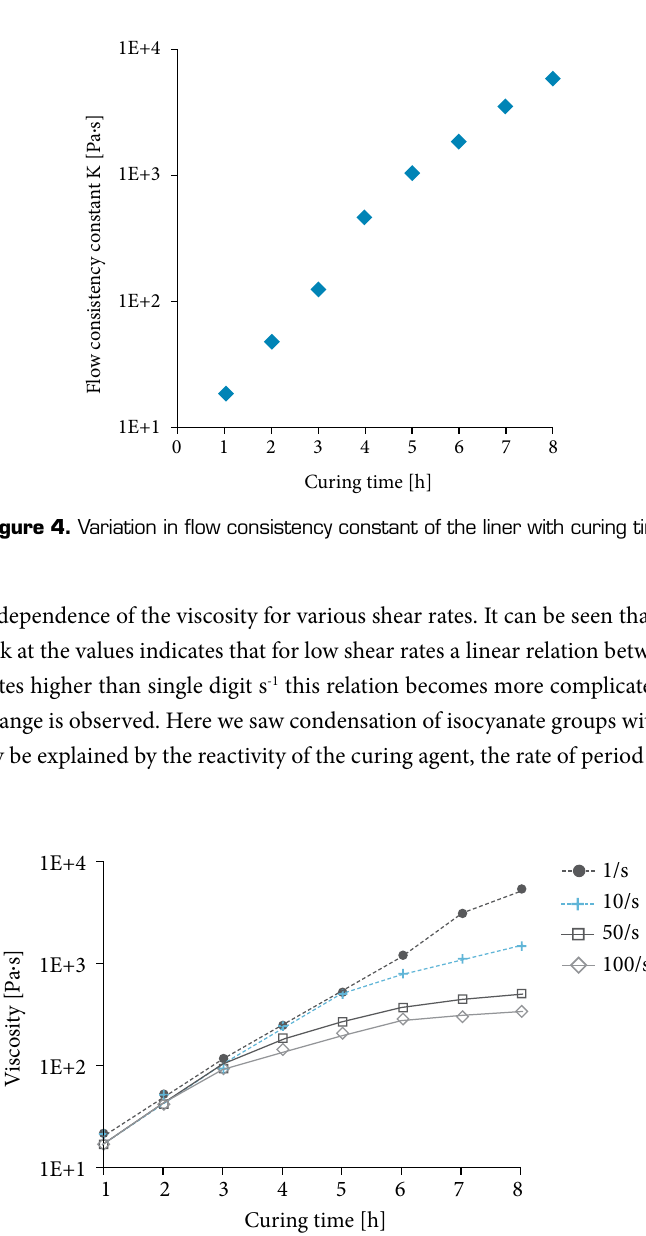
Figure 5. Variation in viscosity of the liner with